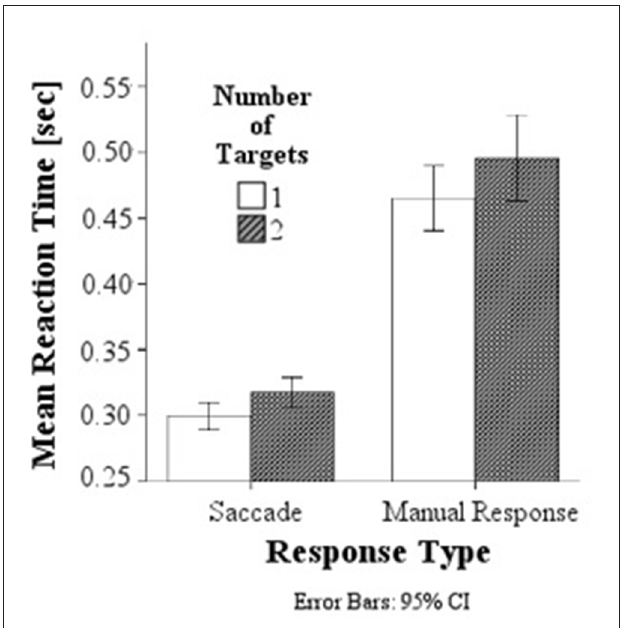
FIGURE 3 | Mean response latencies for saccades and manual responses. Responses are slower in the double target condition than in the single target condition for both saccadic and manual responses.